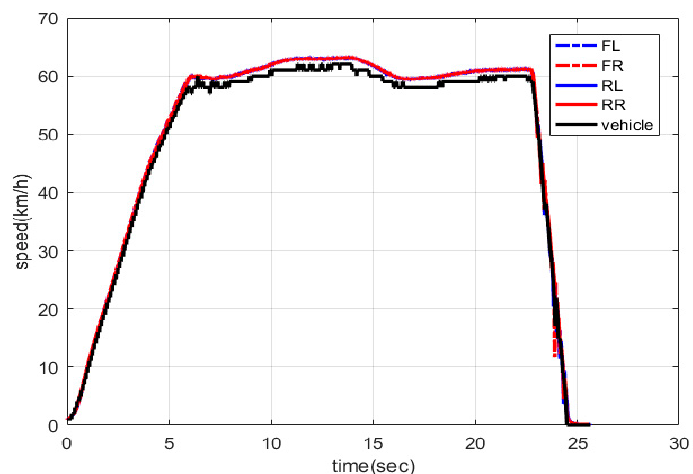
Figure 4. Plotting wheel speed and vehicle speed data.